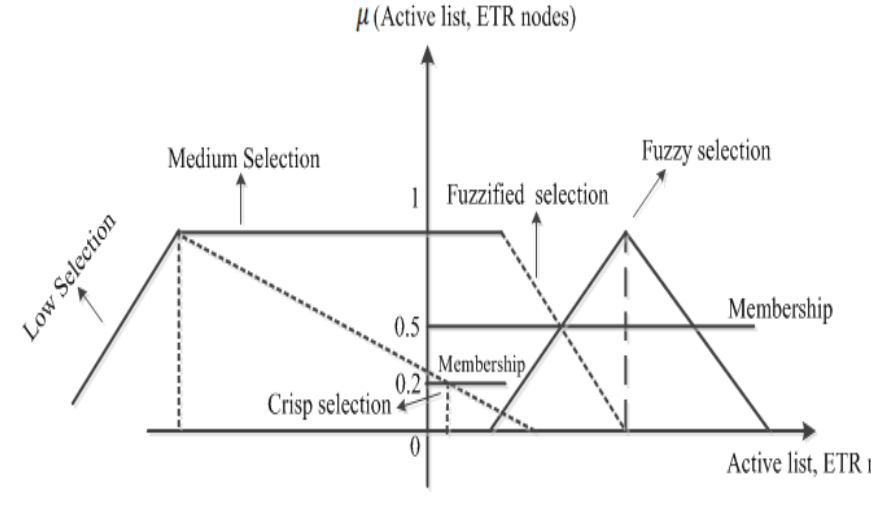
Figure 2. Comparison of fuzzy set, crisp selection and fuzzy